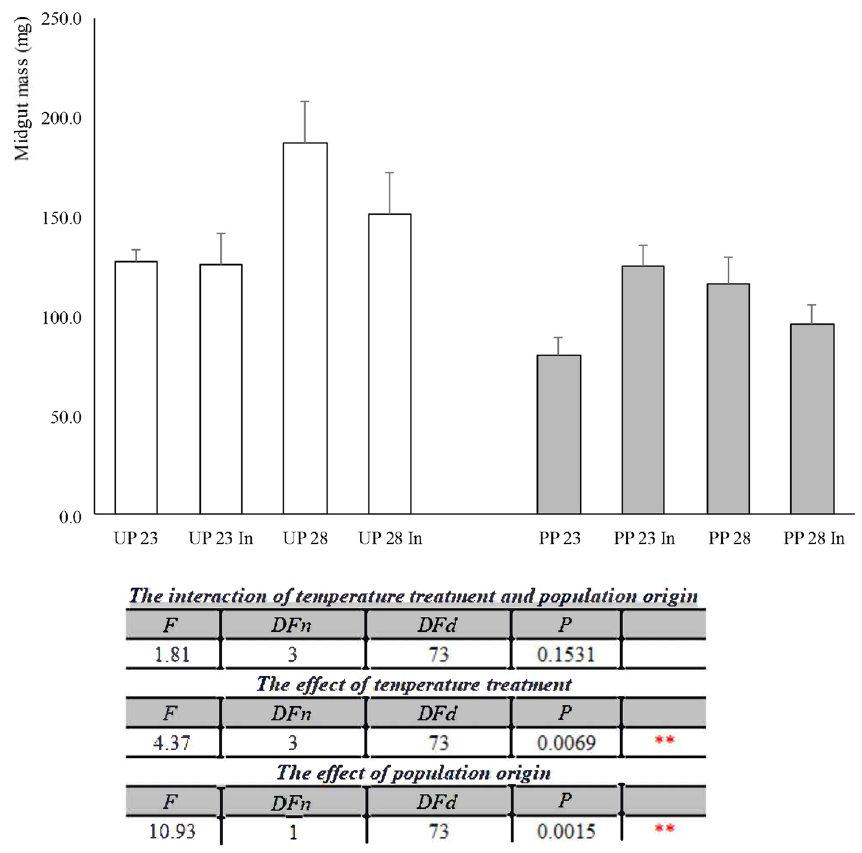
Figure 4. The midgut mass of 5th instar Lymantria dispar larvae exposed to different temperature treatments from unpolluted (UP groups) and polluted forest (PP groups). All abbreviations are the same as in Fig. 1. Significance of the effects of the thermal treatments, population origin, and their interaction on the variance of larval midgut mass with thermal treatments as fixed factor (two-way ANOVA, p ≤